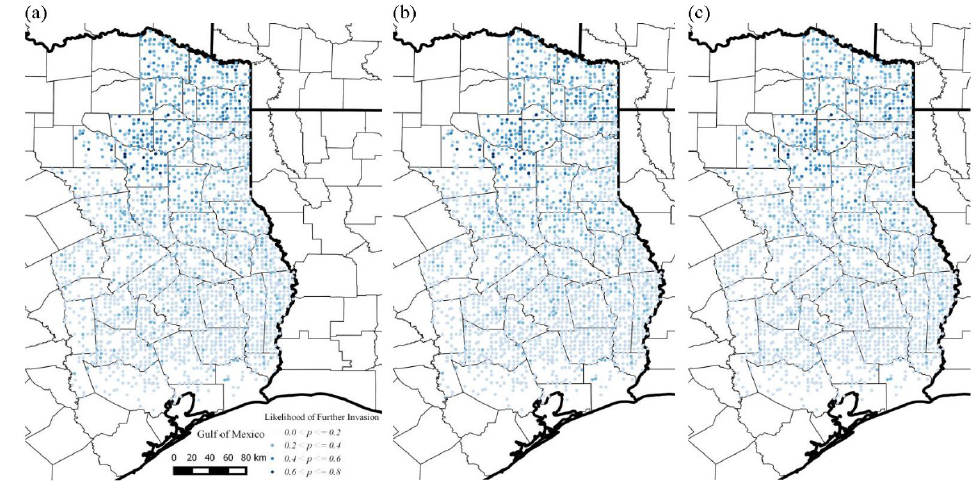
Figure 5. Cont. Figure 5.